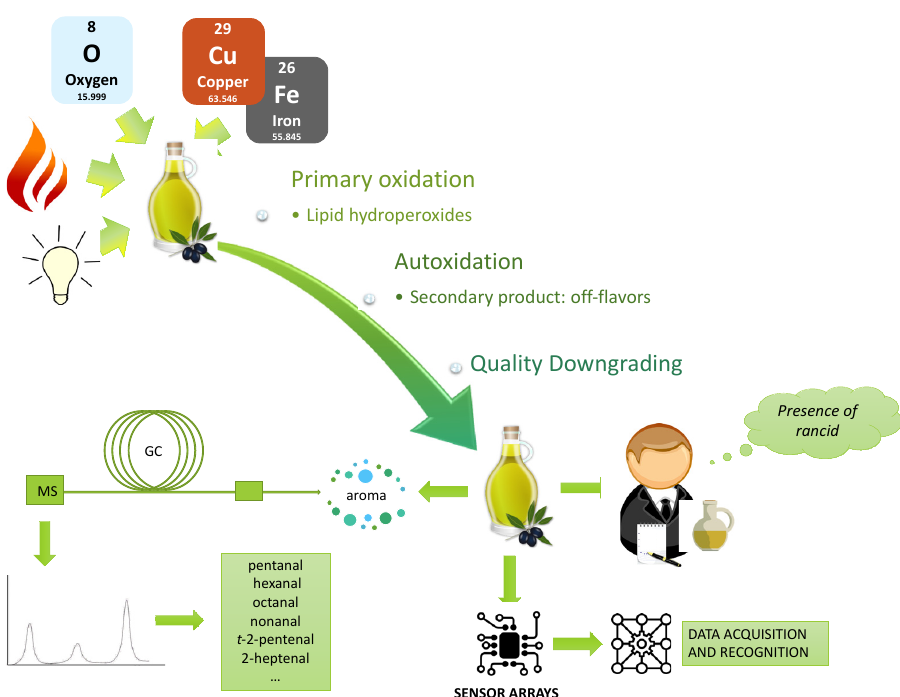
Figure 1. The exposition of VOOs to oxygen or catalyst agents induces the oxidation of unsaturated fatty acids, with the formation of unstable hydroperoxides, which, during autoxidation, form off-flavors (secondary volatile products such as aldehydes, ketones, alkenes and alkanes) responsible for the VOO quality decay.